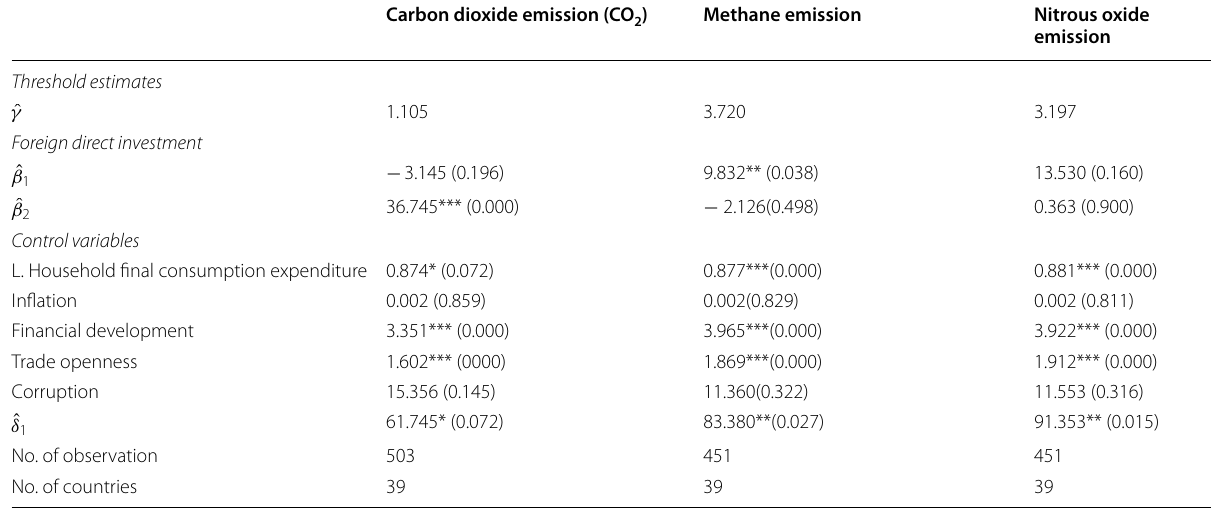
Table 2 Results of the dynamic threshold effect of the environmental degradation on foreign direct investment and poverty reduction (dependent variable: household final consumption expenditure)